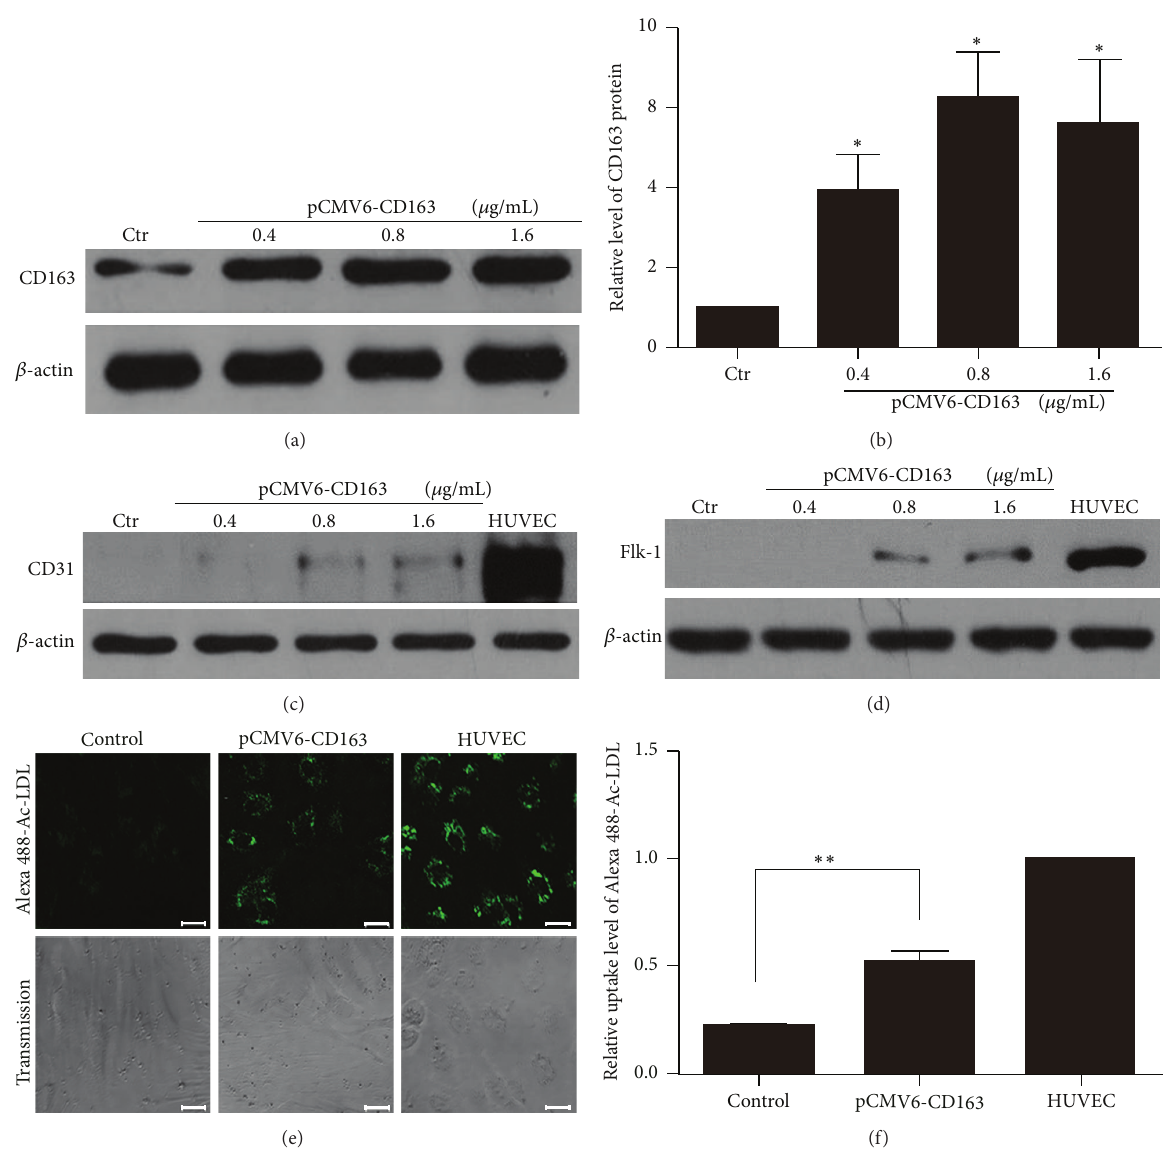
Figure 1: Overexpression of CD163 enhanced the expression of endothelial-associated markers and uptake of Alexa 488-Ac-LDL in BMSCs. For CD163 overexpression, BMSCs were transfected with empty vector pCMV6 (as control) at 1.6 𝜇 g/mL or pCMV6-CD163 at 0.4, 0.8, or 1.6 𝜇 g/mL for 4h and cultured for 48 h. Ctr: control. (a) Western blot analysis of CD163 overexpression efficiency. (b) Relative levels of CD163 protein were calculated based on densitometry analysis. ((c)-(d)) Western blot analysis of the protein level of the endothelial-associated markers CD31 and Flk-1 after being transfected with pCMV6 or pCMV6-CD163 for 48h. (e) Uptake of Alexa 488-Ac-LDL by cells after being transfected with pCMV6 or pCMV6-CD163 at 0.8 𝜇 g/mL for 48 h. Scale bar: 10 𝜇 m. Images are representative of at least 3 independent experiments. (f) Relative uptake level of Alexa 488-Ac-LDL was calculated by LCS lite. The uptake level of HUVEC was set as 1. HUVEC: human umbilical vascular endothelial cells as a positive control. Data are mean ± SEM. ∗ 𝑝 < 0.05 , ∗∗ 𝑝 < 0.01 versus control (Ctr), 𝑛 ≥ 3